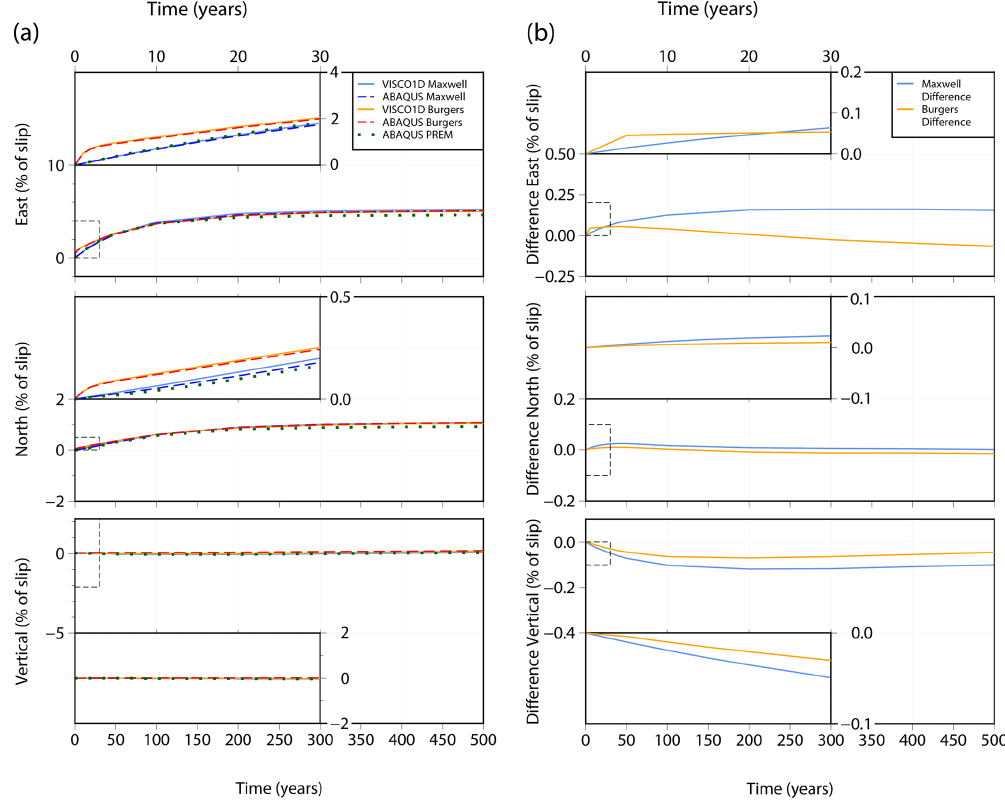
Figure 7. As for Fig. 6 but for a location 300km perpendicular to the fault in Fig. 5. Note different scales on the y axis.